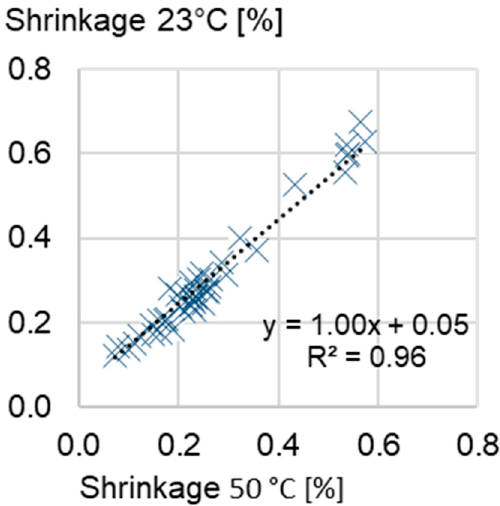
Figure 4. The correlation of the shrinkage (6 h, 24 h, and 240 h) measured at 50 °C and after cooling to 23 °C. The y-axis intercept was intentionally set as 0.05 as this value represents the calculated thermal elongation.